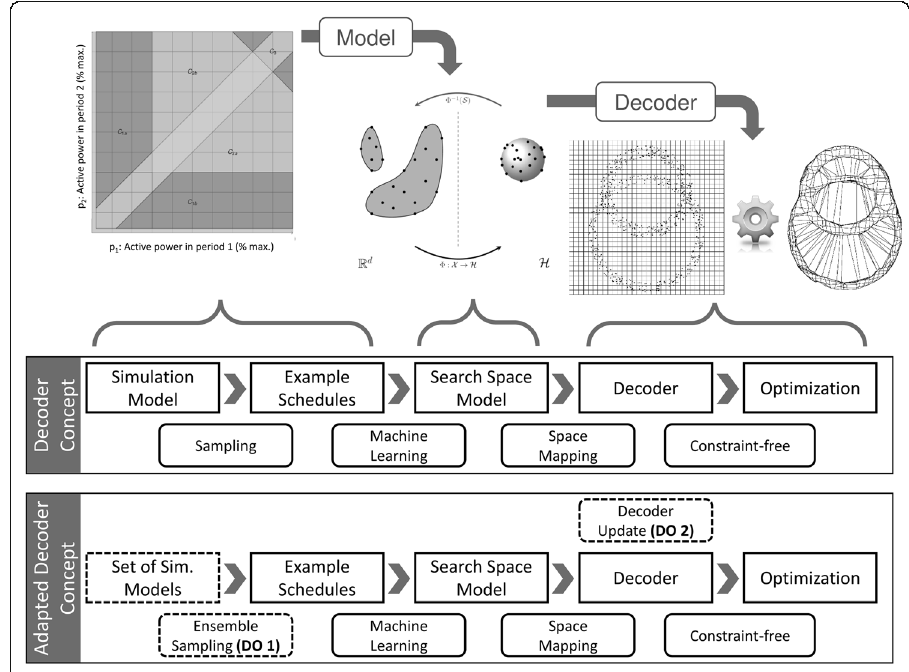
Fig. 2 Process chain of decoder approach according to (Bremer 2015) and intended adaptions/extensions (denoted by dashed